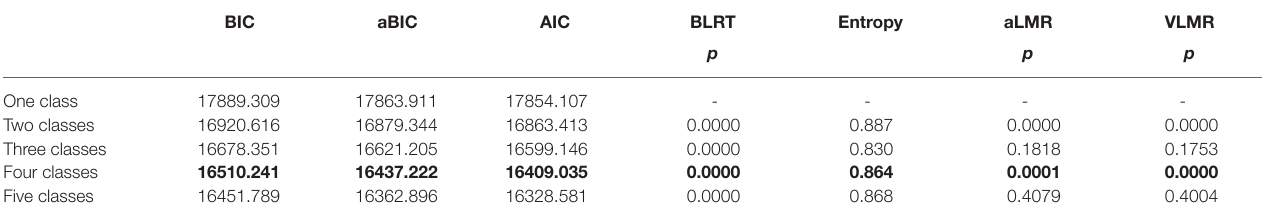
TABLE 1 | Fit indices for latent profile